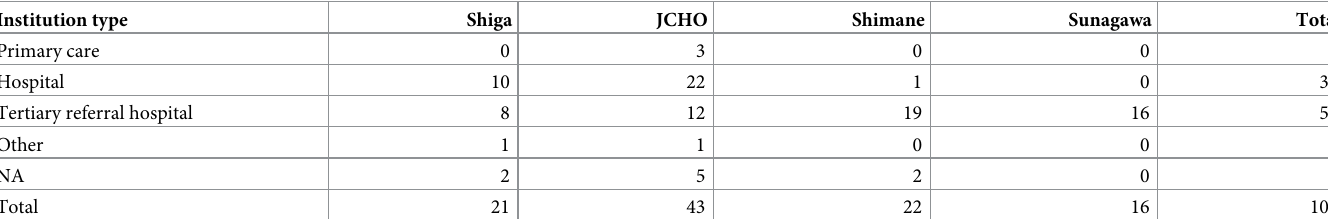
Table 4. Participant profiles by institution type.